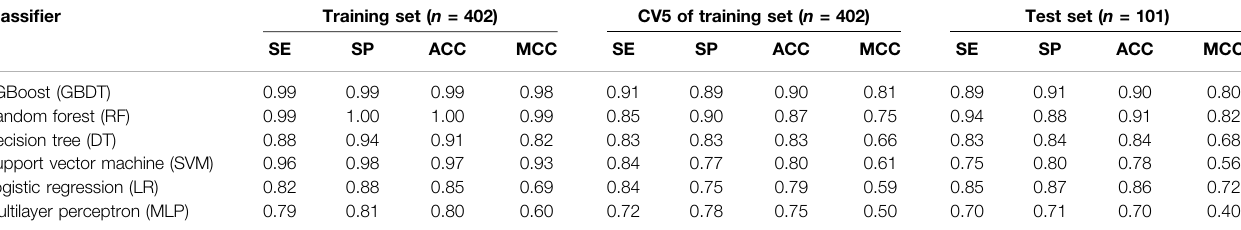
TABLE 1 | The layout of prediction performances of machine learning models assessed by strati fi ed 5-fold cross-validation for the training set and test set. Classi fi er Training set ( n = 402) CV5 of training set ( n = 402) Test set ( n = 101) SE SP ACC MCC SE SP MCC MCC XGBoost